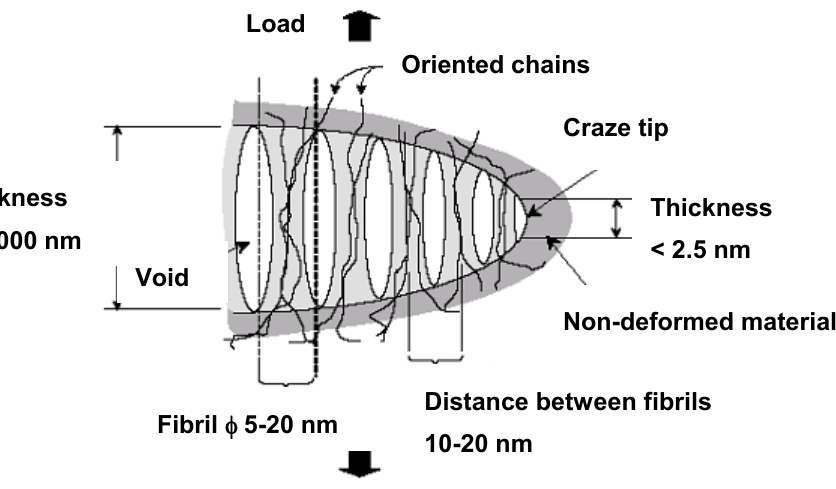
Figure 2. Representation of the ideal structure of a